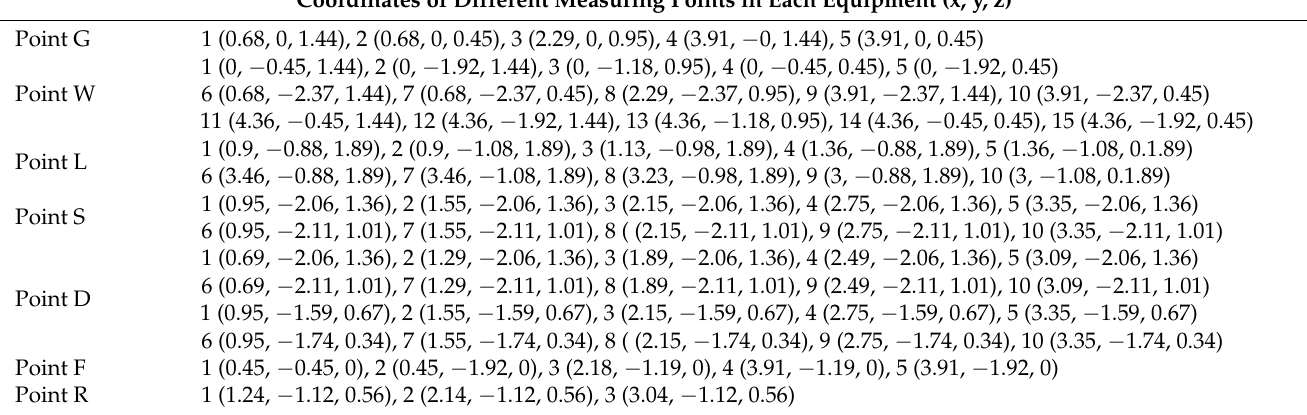
Coordinates of Different Measuring Points in Each Equipment (x, y, z)